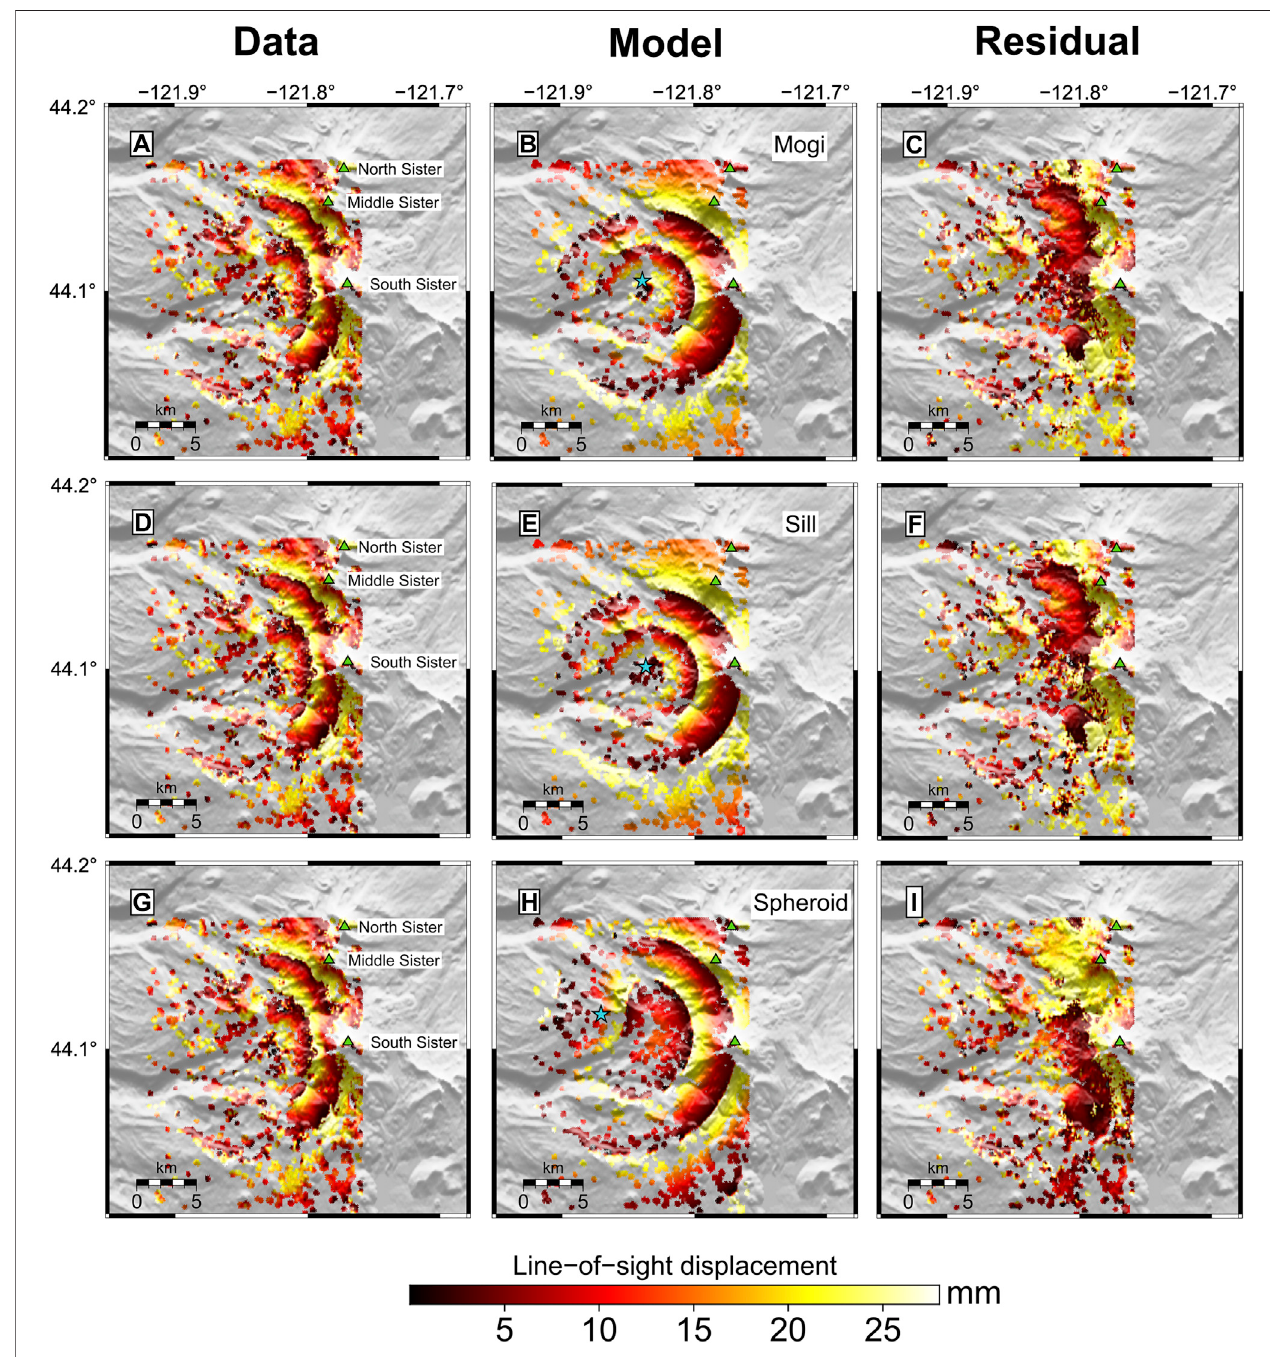
FIGURE4| WrappedInSARdataandmodelresultsforTrack385oftheERSsatellite. (A,D,G) Line-of-sight(LOS)deformationobservedinanearly3 yearsperiod fromAugust24,1997andSeptember17,2000,consideringonlypixelswithcoherence > 0.2.GreentrianglesrepresenttheThreeSistercomplexvolcanosystem. (B,E, H) Bayesian model and horizontal location for the median a posteriori probability solution (blue star) for a predicted Mogi, sill-like and prolate spheroid source, respectively. (C, F, I) Residual maps for Mogi, sill-like and prolate spheroid source. The model parameters results are presented in Figure 5 and Tables 1 , 2 .